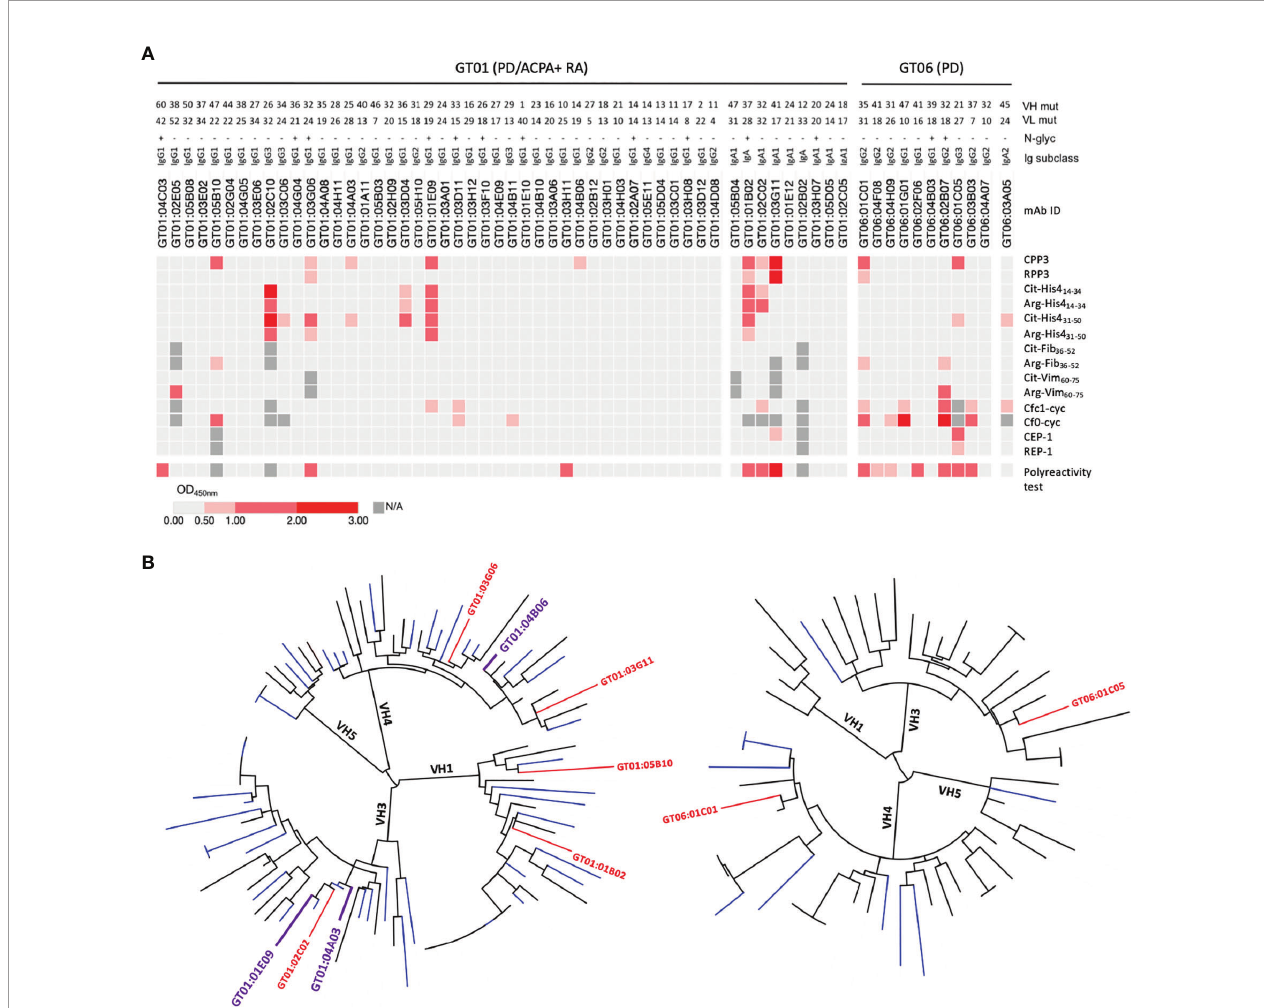
FIGURE 3 | Recombinant gingival tissue mAbs exhibit citrulline-reactivity. (A) ELISA results shown as a heat map, for 52 mAbs generated from a fresh GT biopsy of a PD patient with ACPA+ RA (GT01) and 11 GT mAbs generated from a frozen GT biopsy of a PD patient without RA (GT06); colors indicate binding strength (based on OD values; scale shown at the bottom). Peptide antigens include: citrullinated peptides (and arginine-containing equivalents) from Pg (CPP3) and human proteins. The number of mutations (mut) in the variable heavy (VH) and variable light (VL) chains, presence/absence (+/-) of predicted N-linked glycosylation (N-glyc) motifs (N-X-S/T), and the original Ig subclasses are shown. (B) Phylogenetic trees of the VH chain sequences of GT01 (94 sequences) (left), and GT06 (54 sequences) (right), constructed using Phylogeny.fr with MUSCLE alignment and visualized by iTOL v4.4.2. CPP3+ clones are highlighted in plum (no polyreactivity detected) or in red (show polyreactivity). CPP3, citrullinated P .PAD peptide 3; RPP3, arginine-containing version of CPP3; Cit, citrulline; Arg, arginine; His4, histone-4; Fib, fi brinogen; Vim, vimentin; Cfc1-cyc, cyclic citrullinated fi laggrin peptide 1; Cf0-cyc; arginine-containing version of Cfc1-cyc; CEP-1, citrullinated a -enolase peptide 1; REP, arginine-containing version of CEP-1; OD, optical density; N/A, not analysed. Polyreactivity test, ELISA based on the soluble membrane protein fraction of Hek293